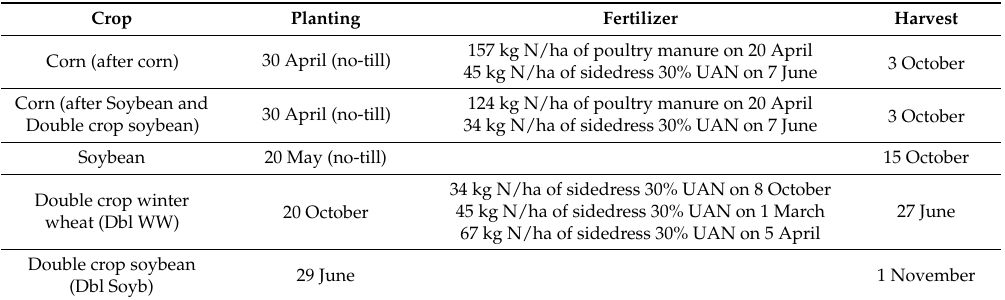
Table 2. The management schedules (adapted from Lee, et al.